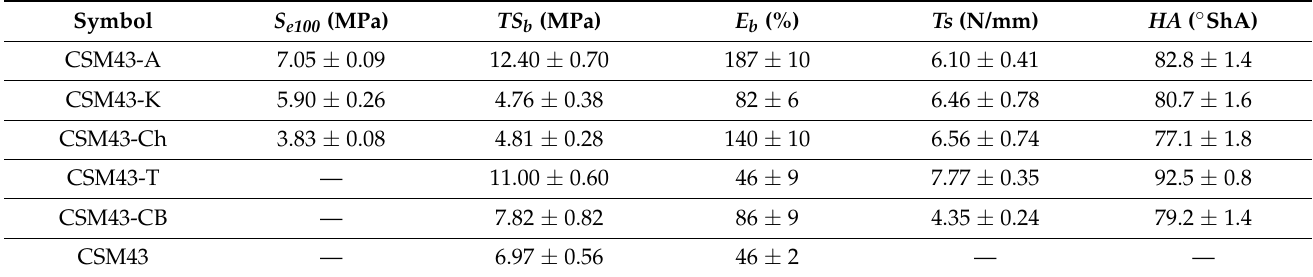
Table 8. Mechanical properties of filled CSM43 vulcanizates; T = 160 ◦ C, t v = 5–15